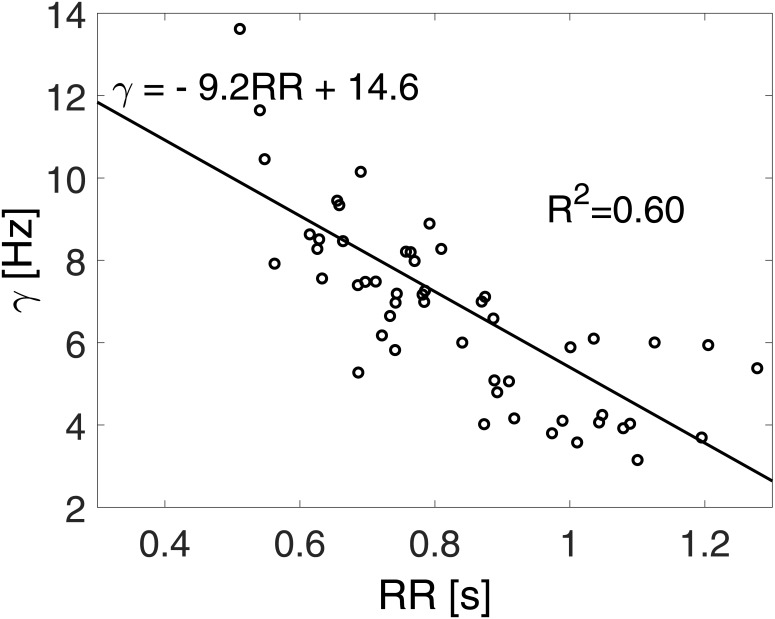
Rate parameter, γ, as a function of the mean RR interval.The Long-Term AF Database [29, 30] contains 84 long-term ECG recordings of subjects with paroxysmal or sustained AF. Record durations vary but cover typically 24 to 25 hours. Among the 84 recordings we focus on those with unimodal distributions having at maximum 10 minutes of other arrhythmias (e.g. sinus bradycardia, idioventricular rhythm, ventricular bigeminy, etc), thereby selecting 26 recordings. For each of these series, two windows of 10,000 beatings have been extracted, allowing the evaluation of 52 power spectrum density functions. It has been observed[31] that γ = S∞-1/2, where S∞ is the flat power spectrum density at the highest frequencies. The rate parameter, γ, has been here evaluated over the 100 highest frequencies for each of the 52 RR series selected. γ values are reported through open circles as function of the mean RR of each chosen window. A linear least squares fitting of the data is introduced (solid line) together with the coefficient of determination, R2 = 0.60. The resulting relation γ = -9.2RR + 14.6 is adopted to obtain γ values for the different HR targets (specific values are reported in Table 3).